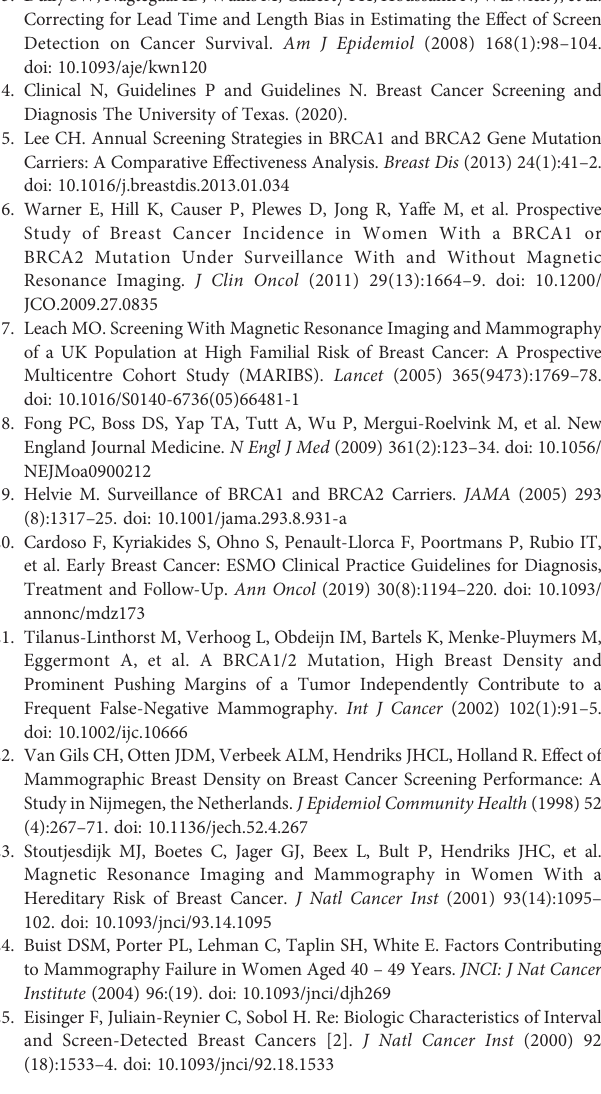
Supplementary Figure 3 | Survival analysis according to BRCA1 and BRCA2 status. BRCA-preDx and BRCA-postDx awareness cohort separated according to BRCA1/2 . Supplementary Table 1 | Univariate and multivariate analyses of overall